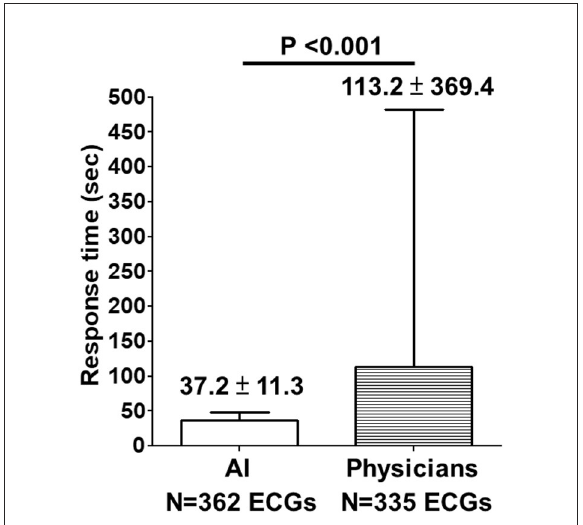
FIGURE4 Comparison of response time between AI and physicians on prehospital ECGs. Between July 17, 2021, and March 26, 2022, the proposed AI model classified a total of 362 prehospital 12-lead ECGs as “STEMI” or “Not STEMI”, obtained from 275 consecutive patients who had called the 119 dispatch centers of the fire stations in Taichung City and Nantou County for symptoms of chest pain or shortness of breath. The AI’s response time to the EMTs in ambulance vehicles was 37.2 ± 11.3s, which was shorter than the online physicians’ response time (113.2 ± 369.4s, P < 0.001) from 11 other fire stations with no AI implementation after analyzing another set of 335 prehospital 12-lead